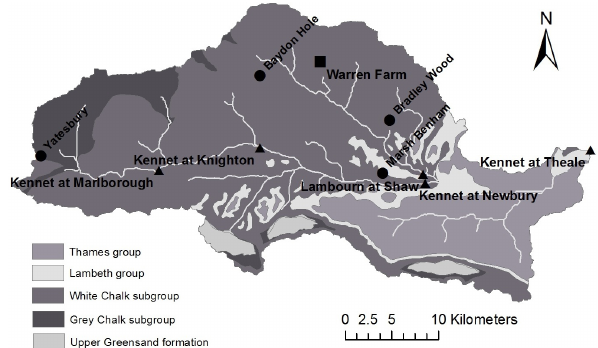
Figure 1. Hydrogeological map of the Kennet catchment. The square indicates the Warren Farm site, the triangles are flow gauging stations, and the circles are observational